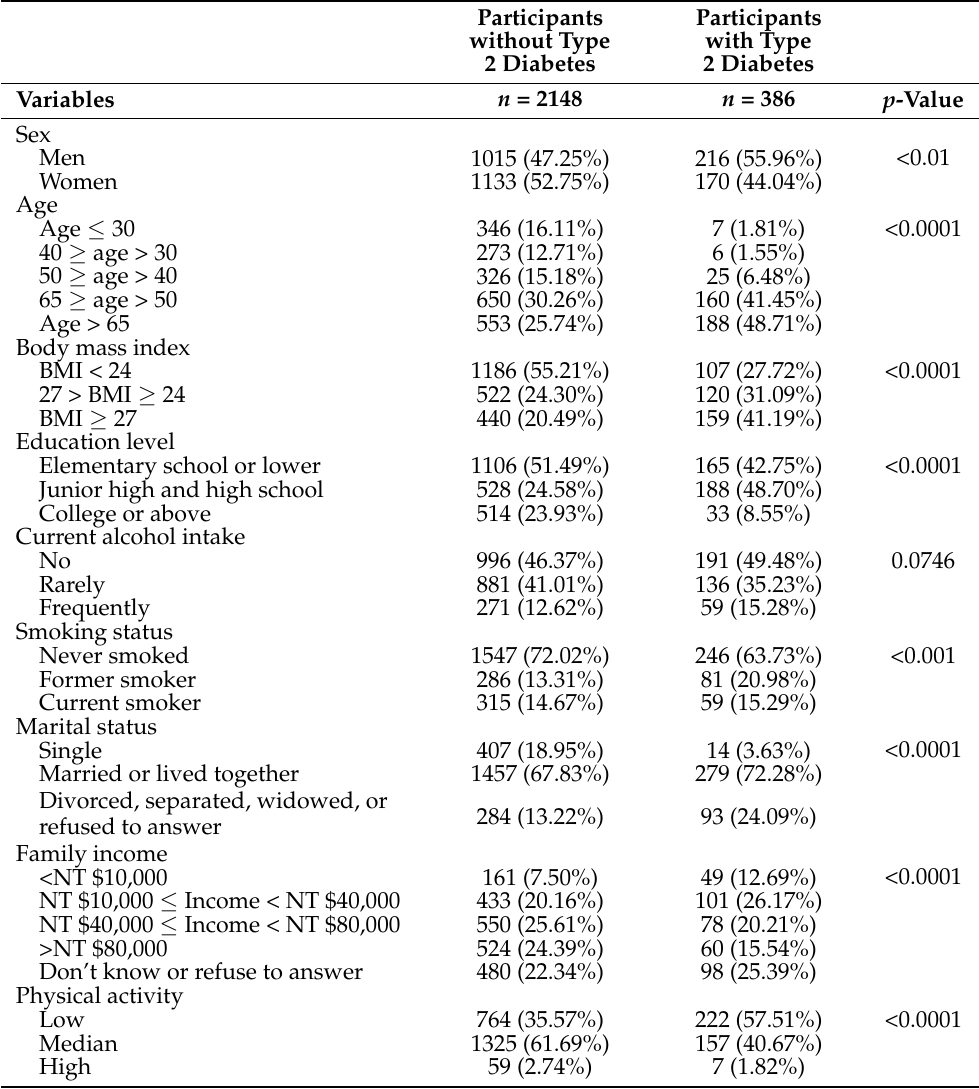
Table 1. Demographic descriptions of included participants. ( n =